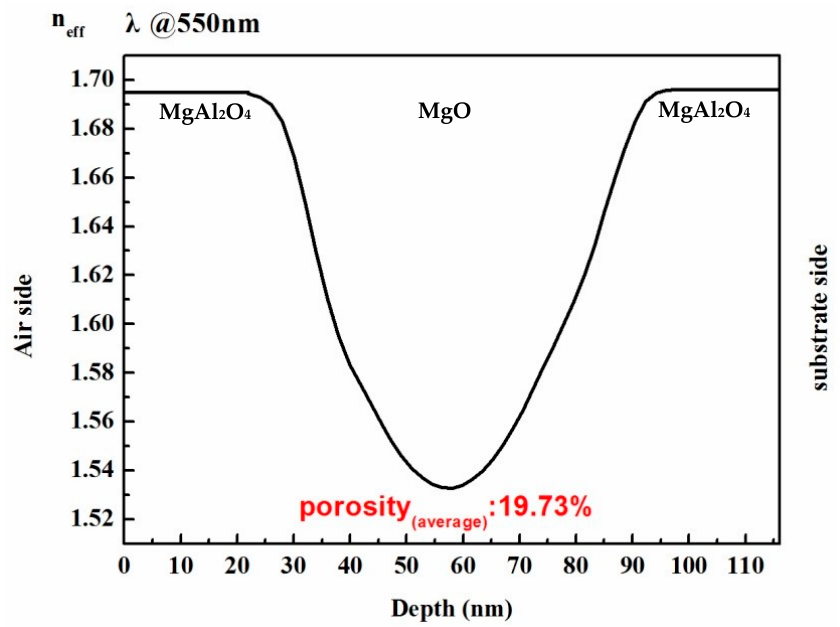
Figure 4. The inhomogeneous index profile of MgAl 2 O 4 /MgO with void/MgAl 2 O 4 .